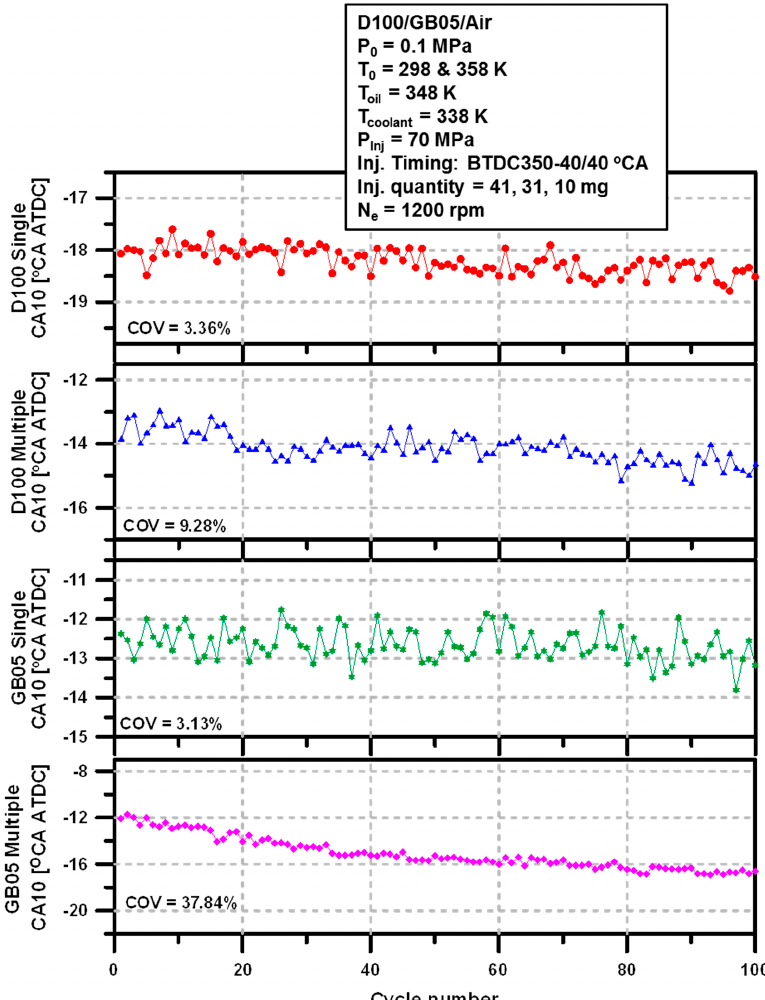
Figure 12. Cycle-by-cycle variations in CA10 under different conditions [Reprinted from Fuel, Vol.